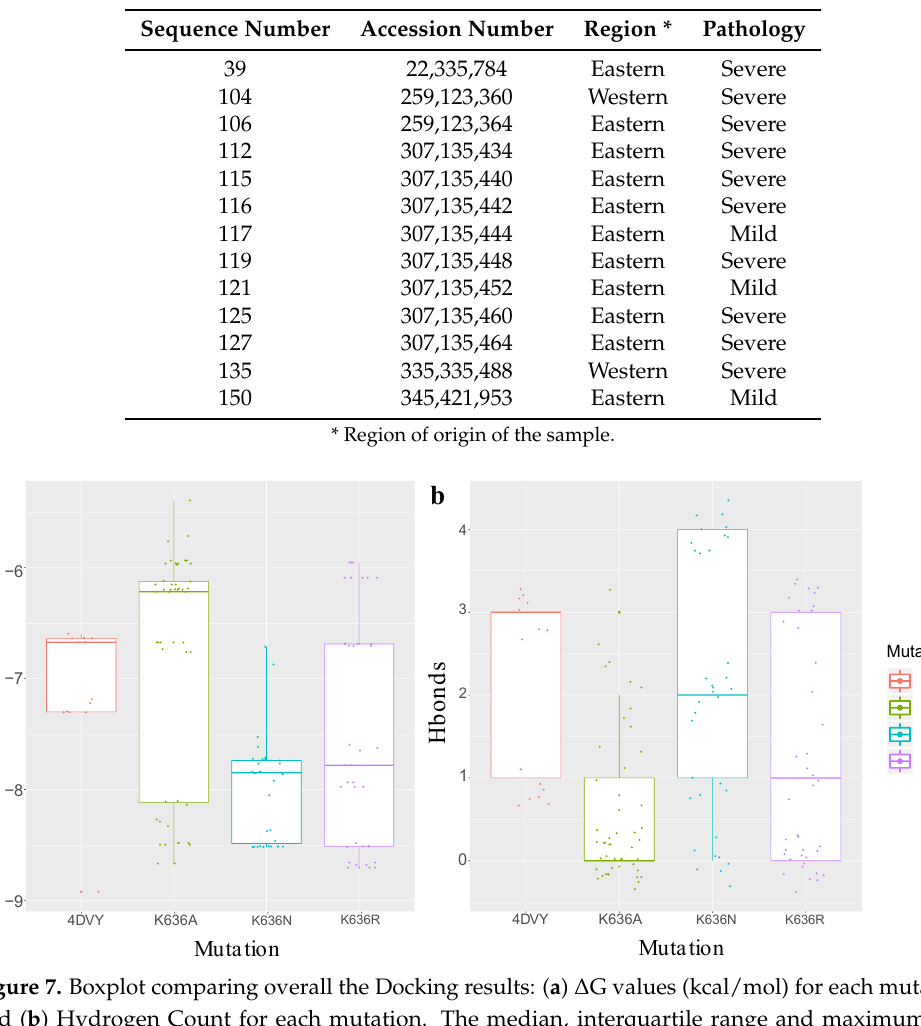
Table 2. Sequences from the dataset with the K636N mutation.